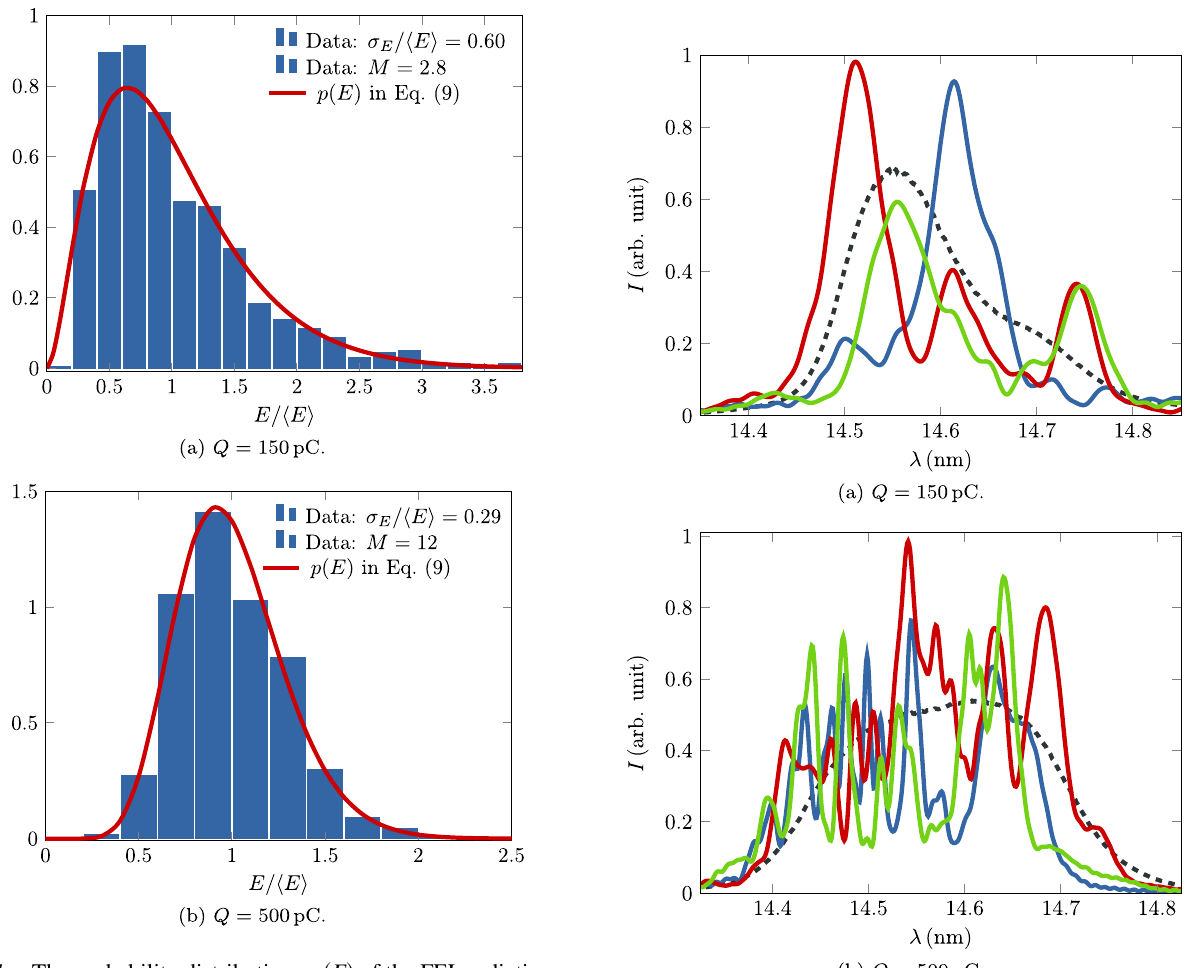
shots.FIG. 7. The probability distributions p ð E Þ of the FEL radiation pulse energy E of soft x-ray pulses at the end of the exponential gain regime for electron bunch charges of (a) 150 pC and (b) 500 pC. The histograms (blue bars) represent the data with the relative radiation pulse energy spread (cid:4) E = h E i , and the solid curve (red lines) show the gamma distribution using M ¼ 2 : 8 and 12 (modes) for 150 and 500 pC,